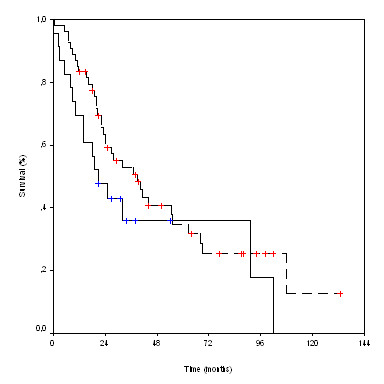
Survival according to Her-2/neu status. ---- HER-2/Neu neg.  HER-2/Neu pos.